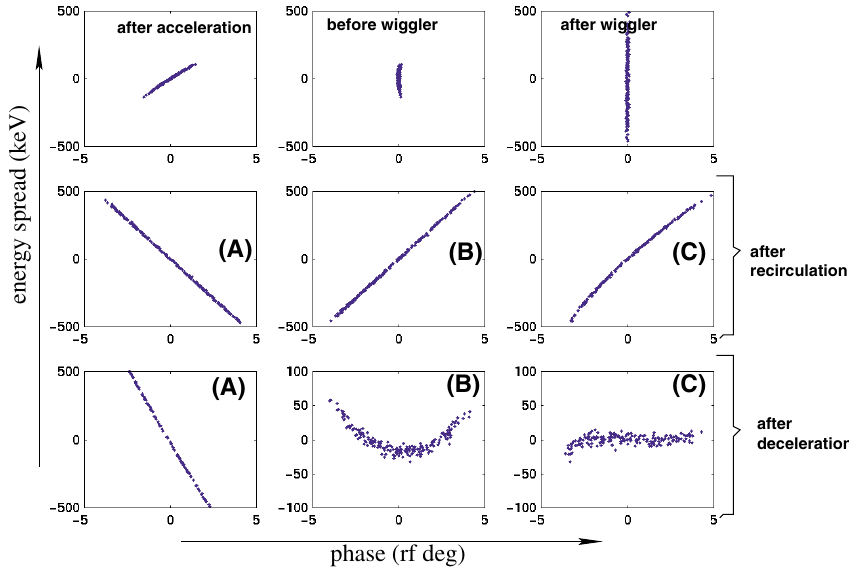
FIG. 2. (Color) Energy compression scheme: The first row (from left to right) presents the longitudinal phase space at the linac exit, after the compression chicane, and just after the wiggler interaction has taken place; the second row shows longitudinal phase space at the entrance of the linac just prior to deceleration for three different choices of R 0 m; and for (c) 0.2 and 3.0 m]. The results for the three cases after deceleration are shown in the third